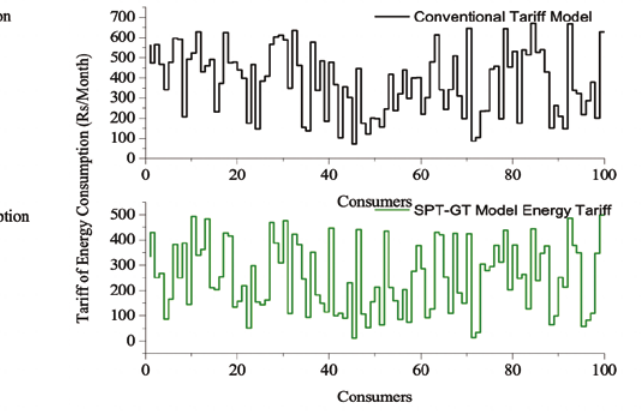
Figure 2: Comparative Electricity Tariff of SPT-GT model and Conventio- nal Model for Agricultural